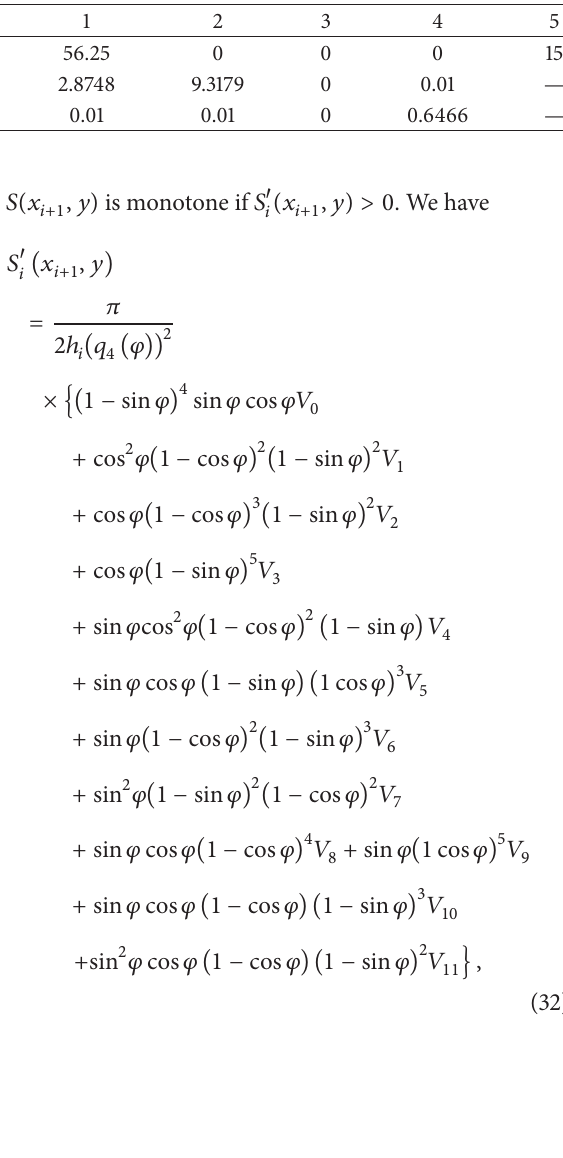
Table 4: Numerical results corresponding to Figure